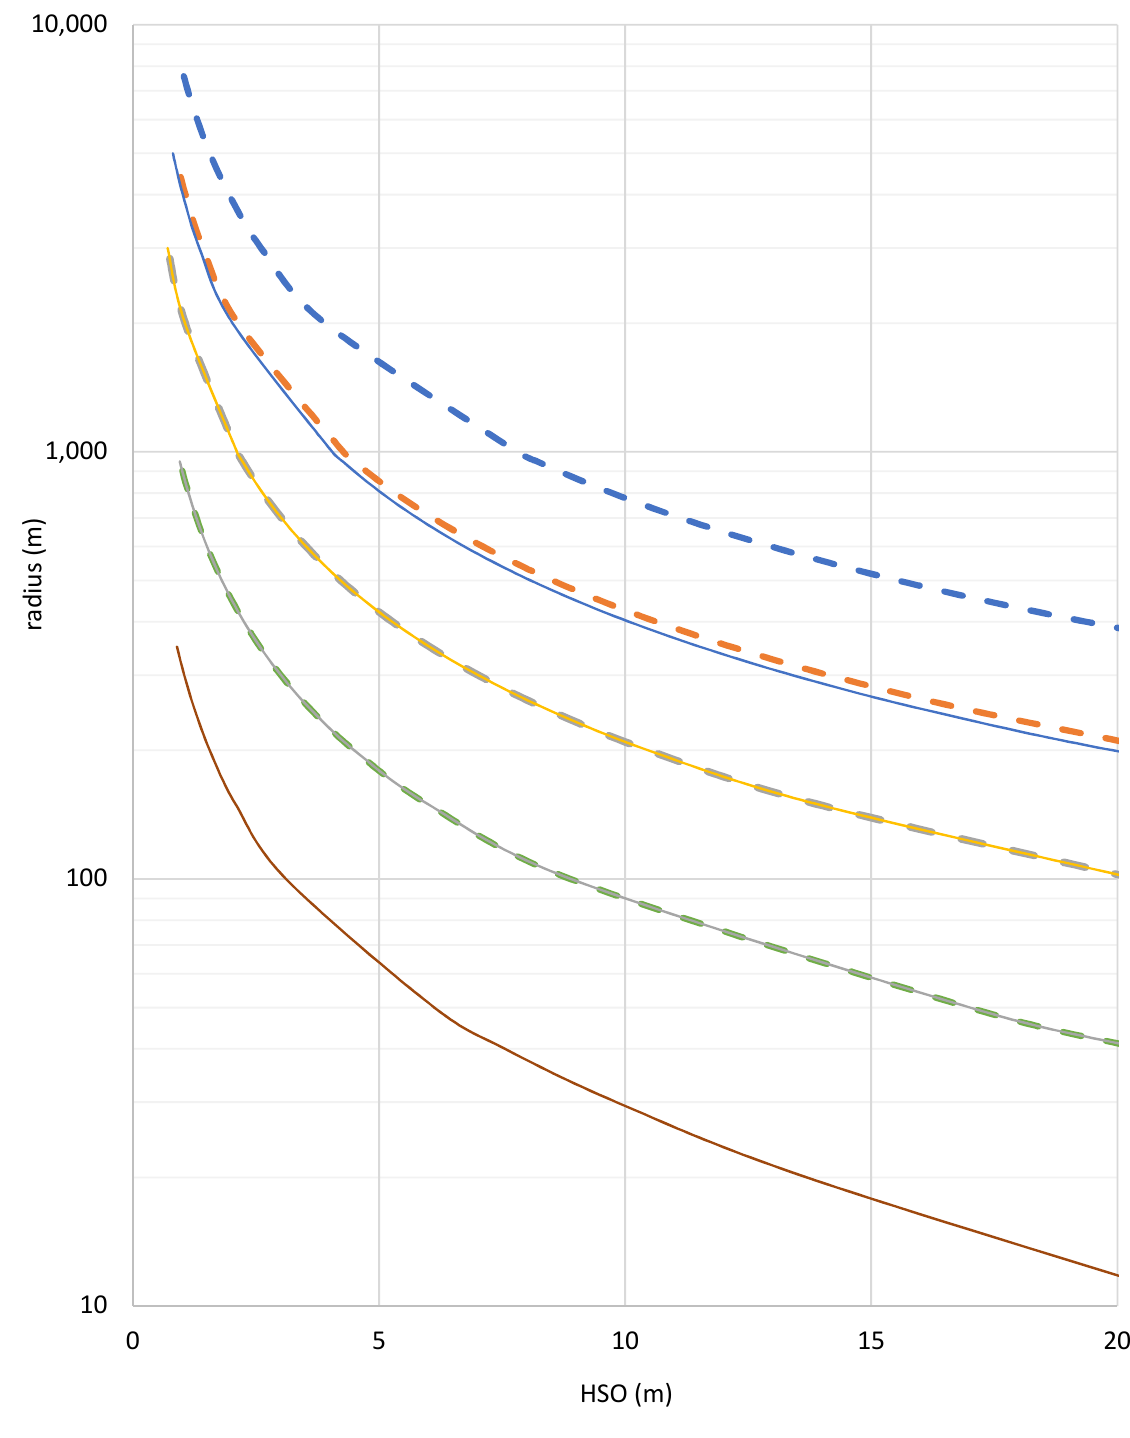
Figure 5. Design Controls for Stopping Sight Distance on Horizontal Curves for human driving and AVs.